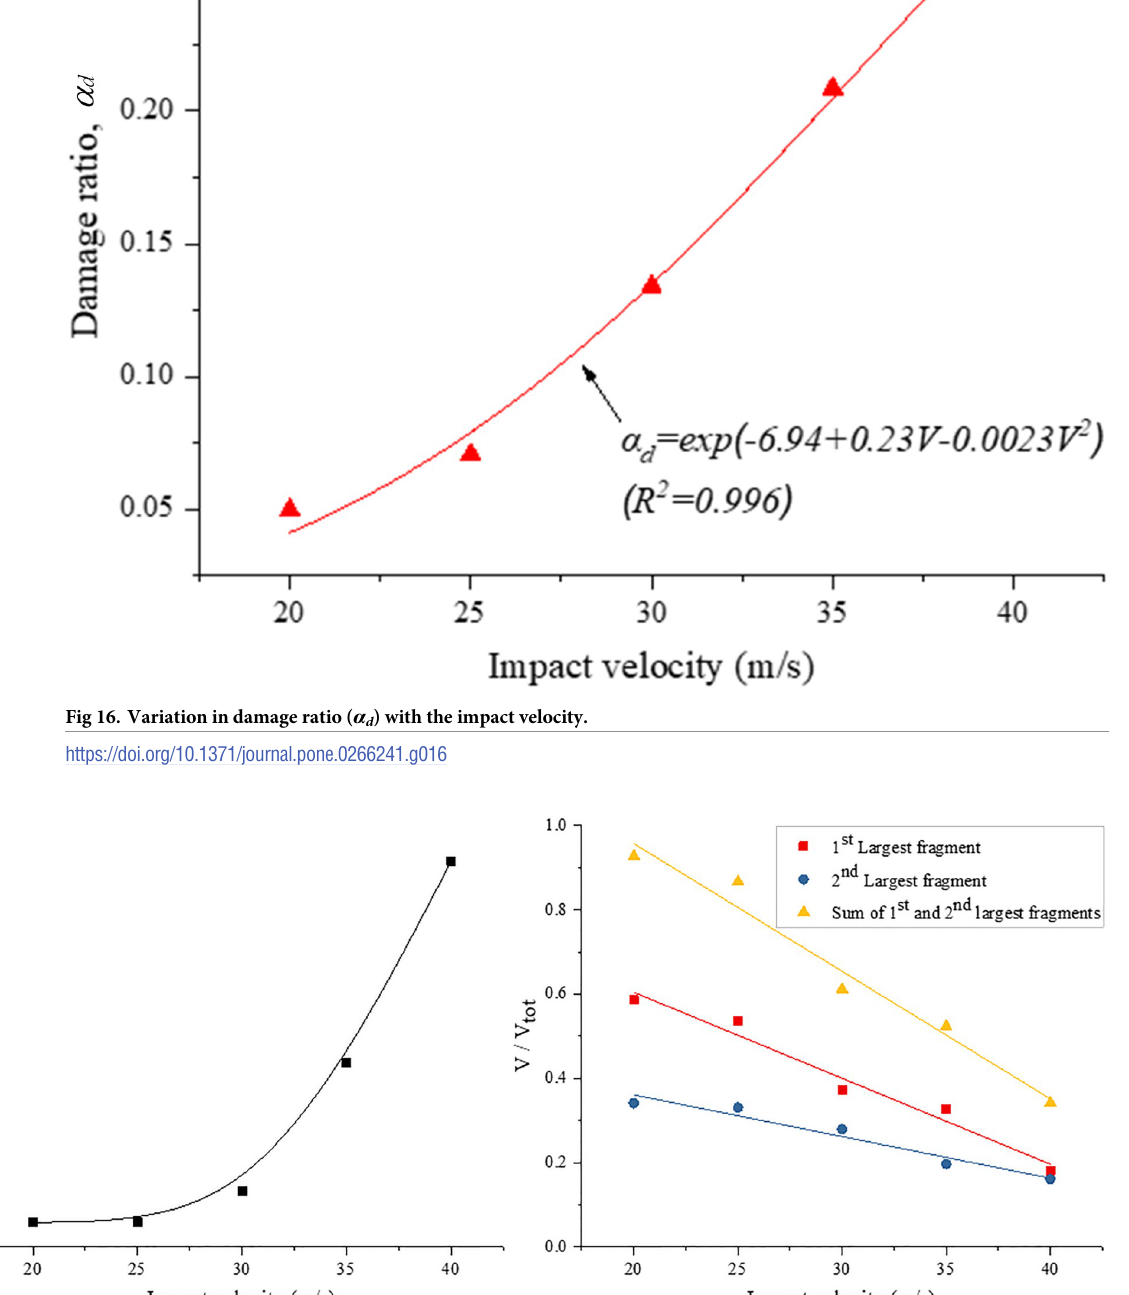
PLOS ONE | https://doi.org/10.1371/journal.pone.0266241 April 7,